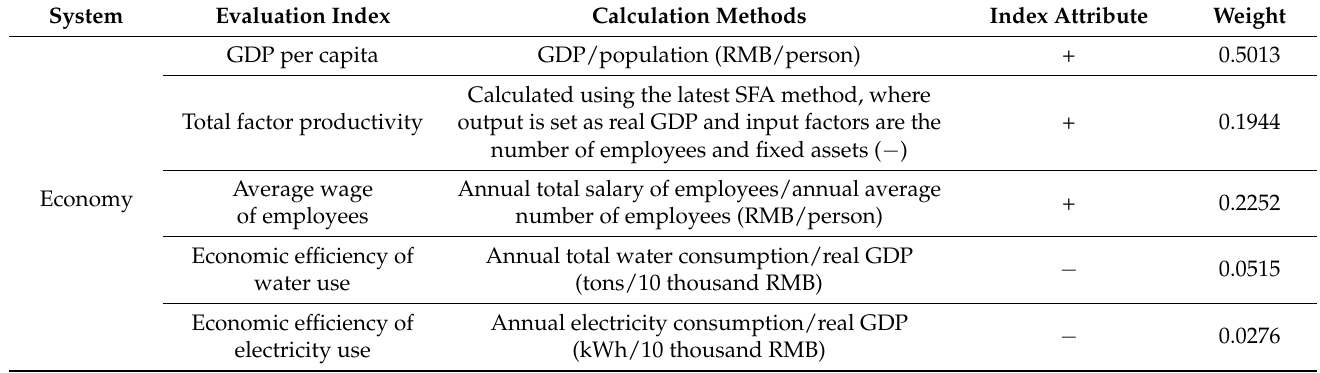
Table 1. Evaluation index system for regional